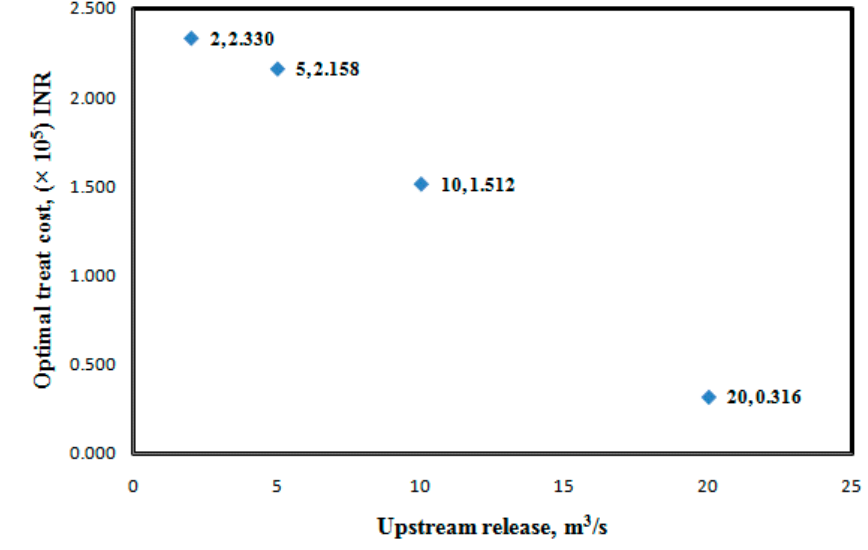
Figure 5. Optimal cost for different upstream releases.